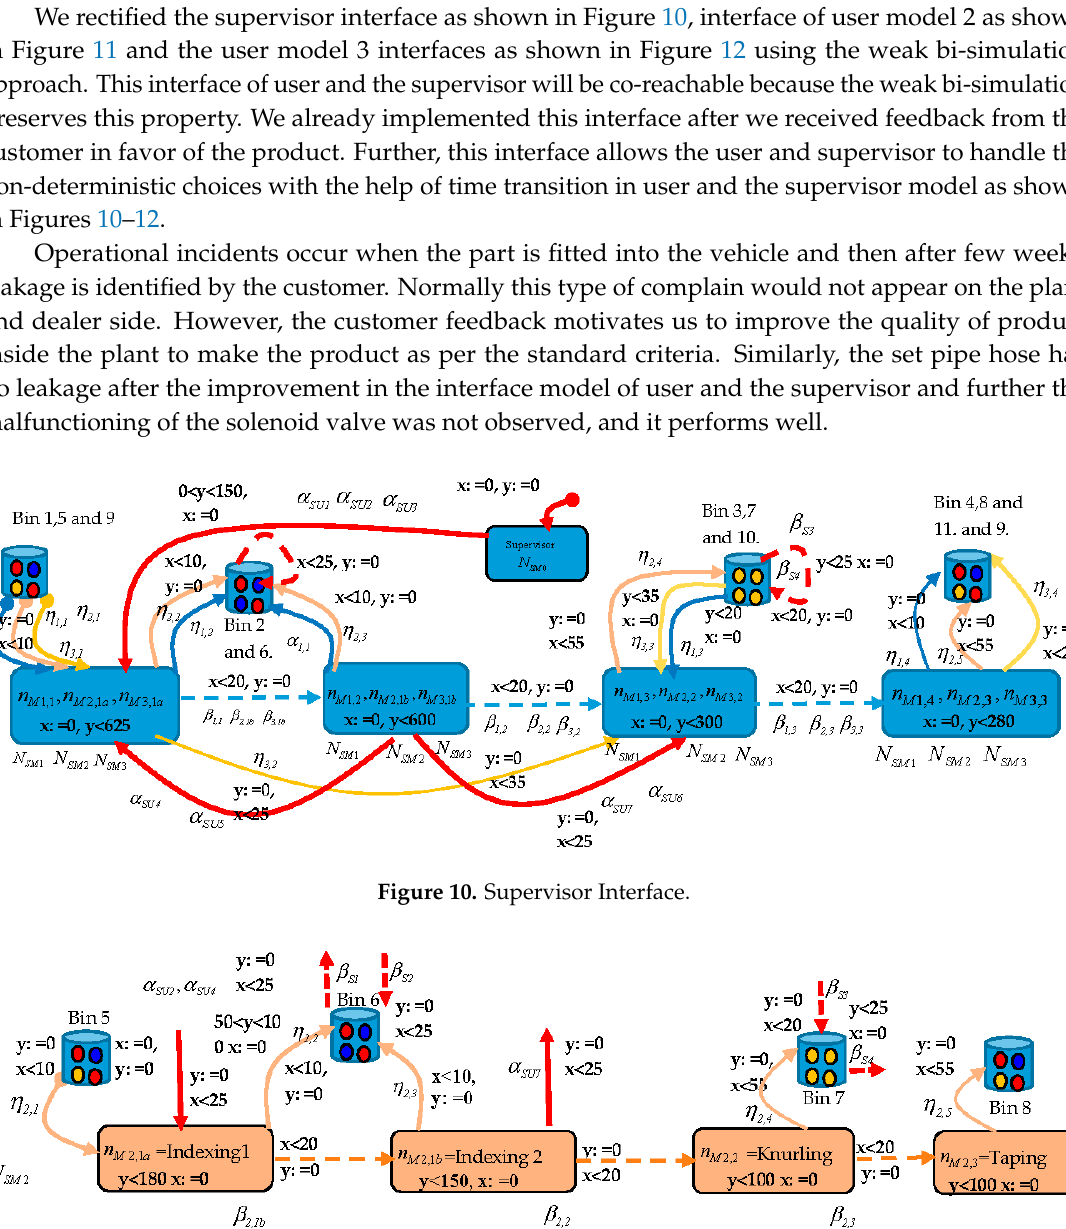
Figure 11. Interface Model of User #2 .